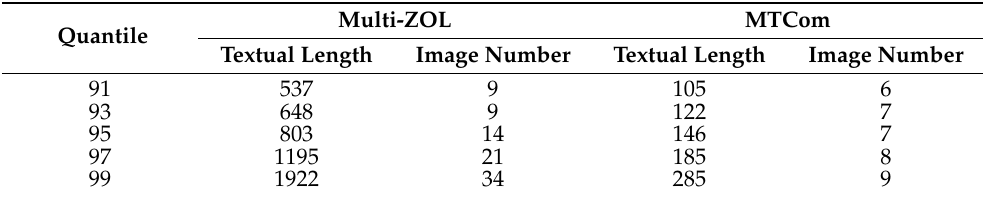
Table 6. The quantile statistics of context length and image number of samples on two multi- modal